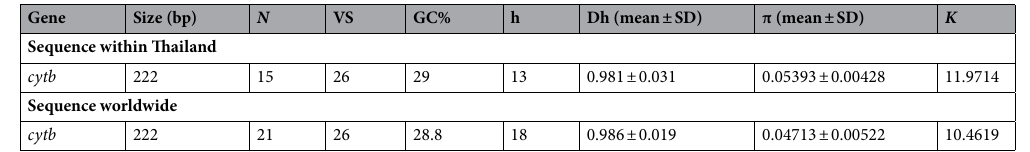
Table 5. Polymorphism and genetic diversity of L. sabrazesi cytb gene sequences as detected in chickens in Thailand and other countries. N: number of analyzed sequences; VS: number of variable sites; GC: G ×